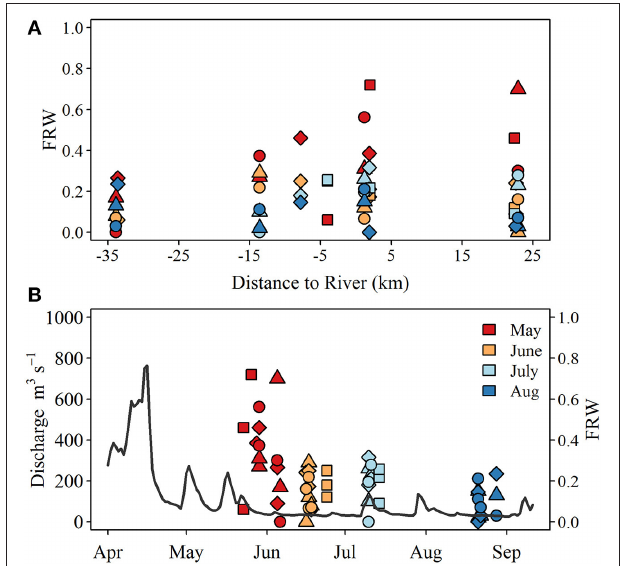
FIGURE 2 | (A) Spatial and (B) temporal pattern of the estimated fraction of river water (FRW) observed at lake sites. Symbols indicate sample type including surface (S; circle), lakebed 10m (LB10; triangle), lakebed 3m (LB3; diamond), and lakebed 1m (LB1; squares). Gray line in (B) represents Grand River discharge measured at the monitoring station located at York (see Figure 1 ). Note the x-axis in (A) denotes the west (negative) and east (positive) distances of each sampling site from the mouth of the Grand